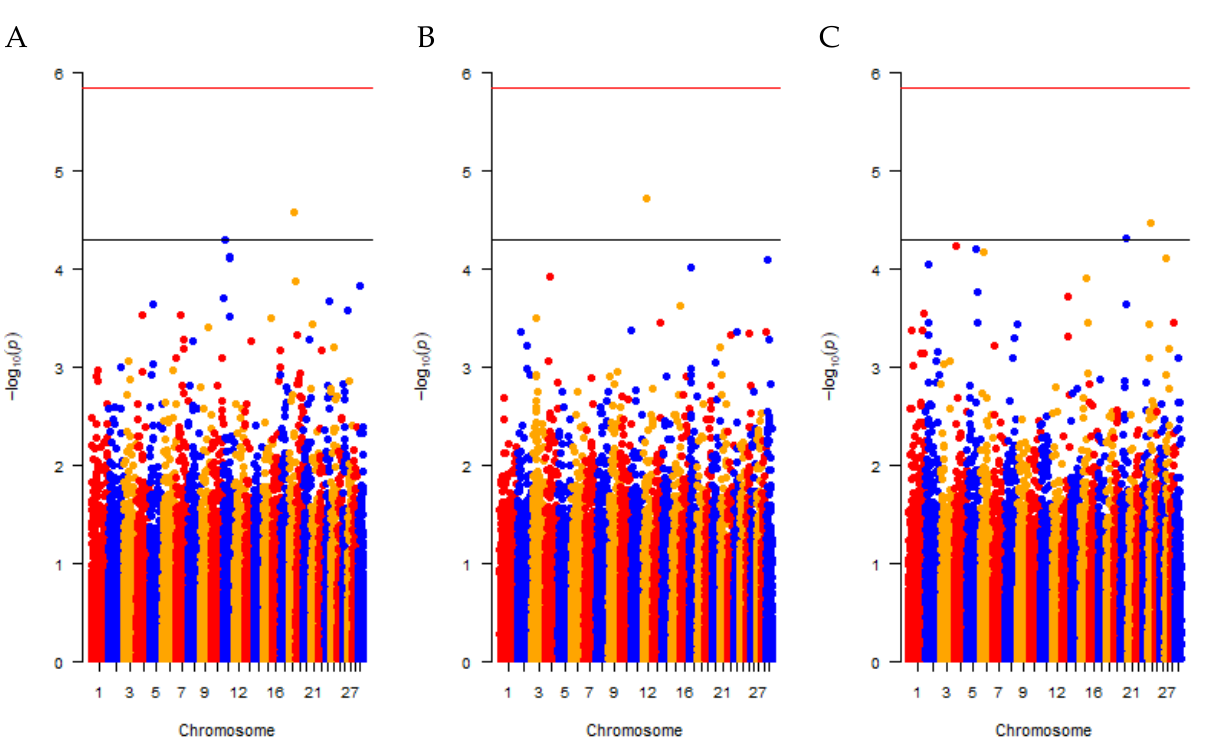
Figure 2. Manhattan plots for the investigated traits. The − log 10 - p -values of the SNP effects and their chromosomal positions are shown for the traits gastrointestinal nematodes ( A ), onchocercosis ( B ) and tick-borne pathogens ( C ). The horizontal bottom black line corresponds to a nominal significance level of p nominal = 5 × 10 − 5 , the top red line to the genome-wide significance level.